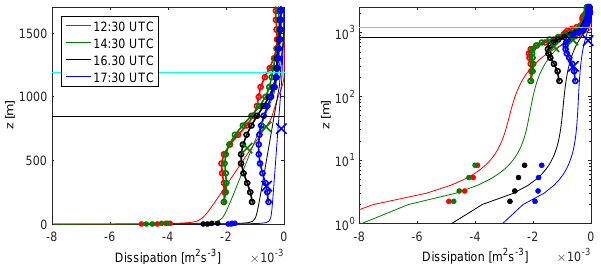
Figure 6. Same as Fig. 3 but for the dissipation term of the TKE budget. Here, smoothed and hourly averaged dissipation estimates are also included from the UHF wind profiler from 175m (lines with circles). Estimates of dissipation from the Piper Aztec aircraft are included as colored crosses. Here, all aircraft flight legs during 1h centered on 14:30 and 17:30UTC, respectively, were averaged for height intervals of